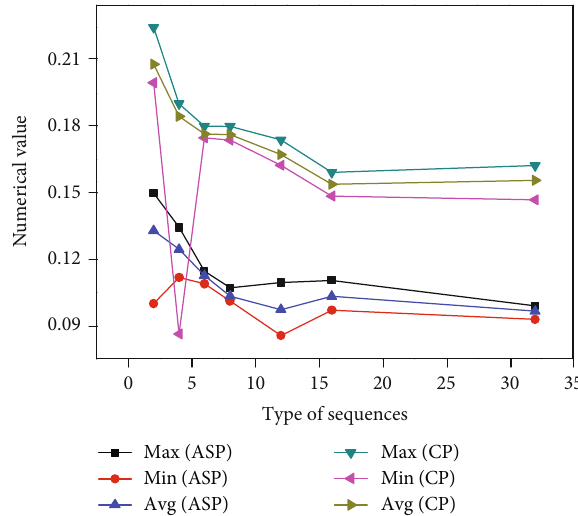
Figure 5: Comparison of relevant properties of di ff erent types of synthetic sequences (the data were obtained from Ref.